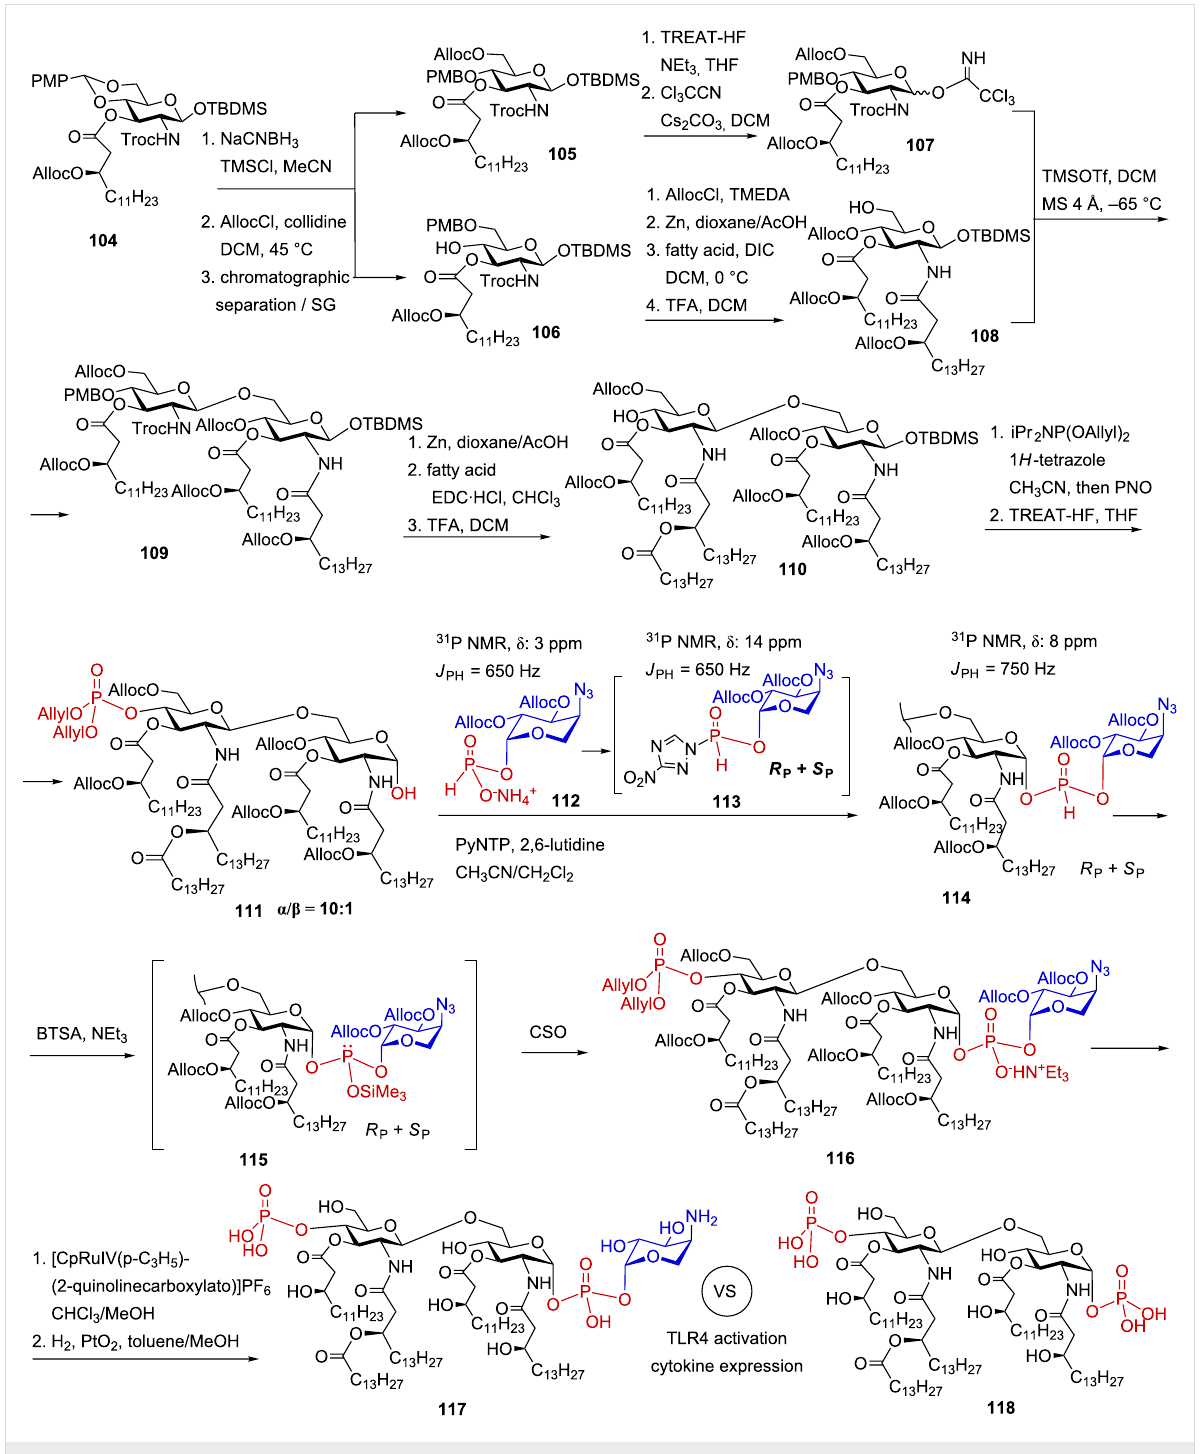
Scheme 13: Synthesis of Burkholderia lipid A containing binary glycosyl phosphodiester linked β -L-Ara4N.